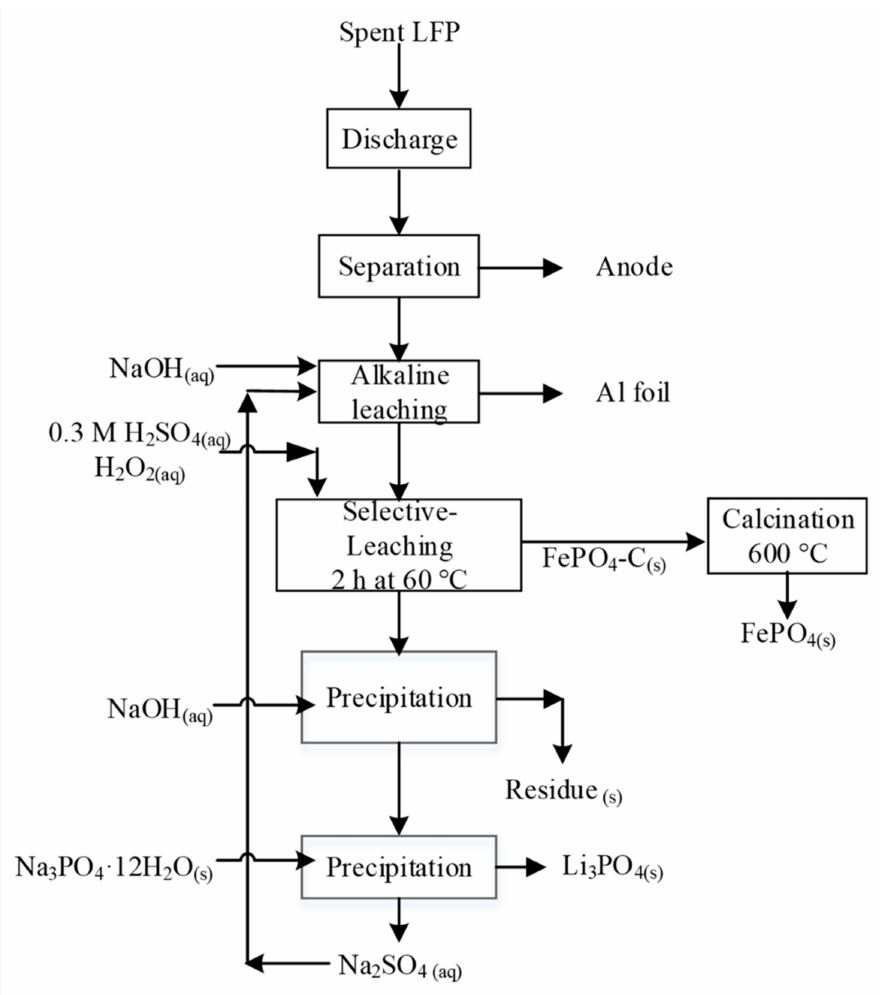
Figure 8. Selective leaching process [58]. Reprinted from Materials, Vol. 13, F. Larouche et al., Progress and Status of Hydrometallurgical and Direct Recycling of Li-Ion Batteries and Beyond,